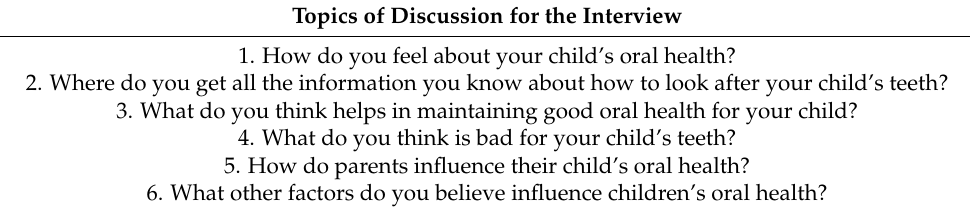
Table 1. Semi-structured interview